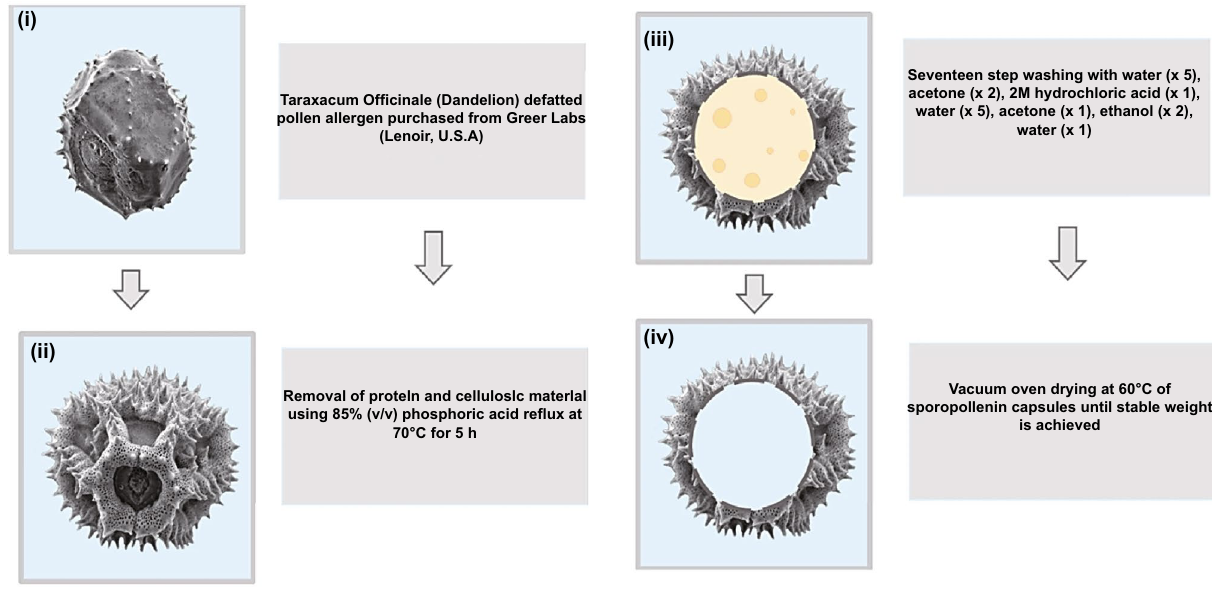
Fig. 3 Extraction procedures of cage-like sporopollenin exine capsules from dandelion pollen grains. Reproduced with permission from Ref. [36] (CC BY 4.0). (Color figure